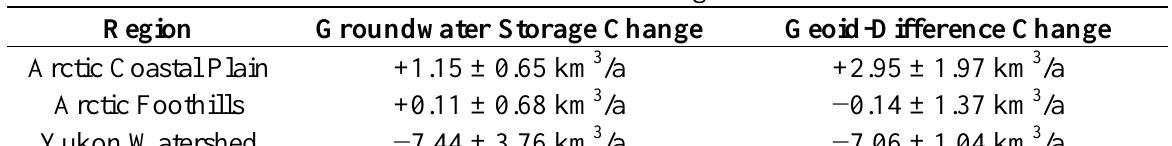
Table 2. Regionalized Groundwater Storage Gradients from GRACE and Geoid-Difference